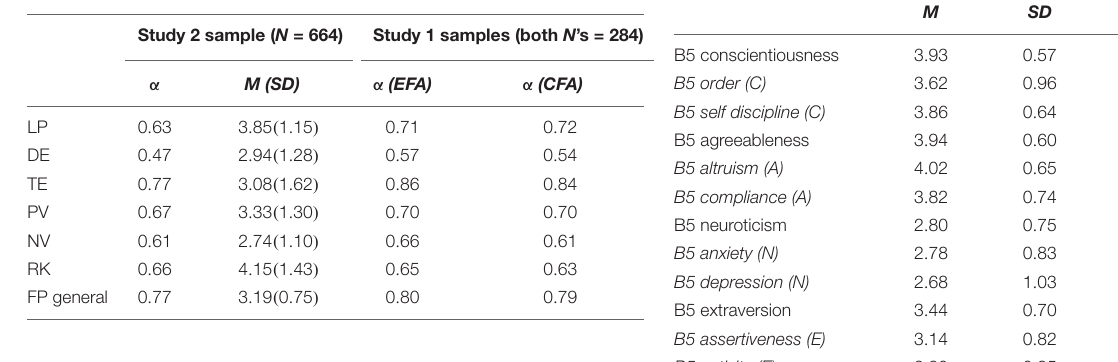
TABLE 3 | Cronbach’s α reliabilities, means, and standard deviations of the FP scores – Study 2 in comparison to Study 1.